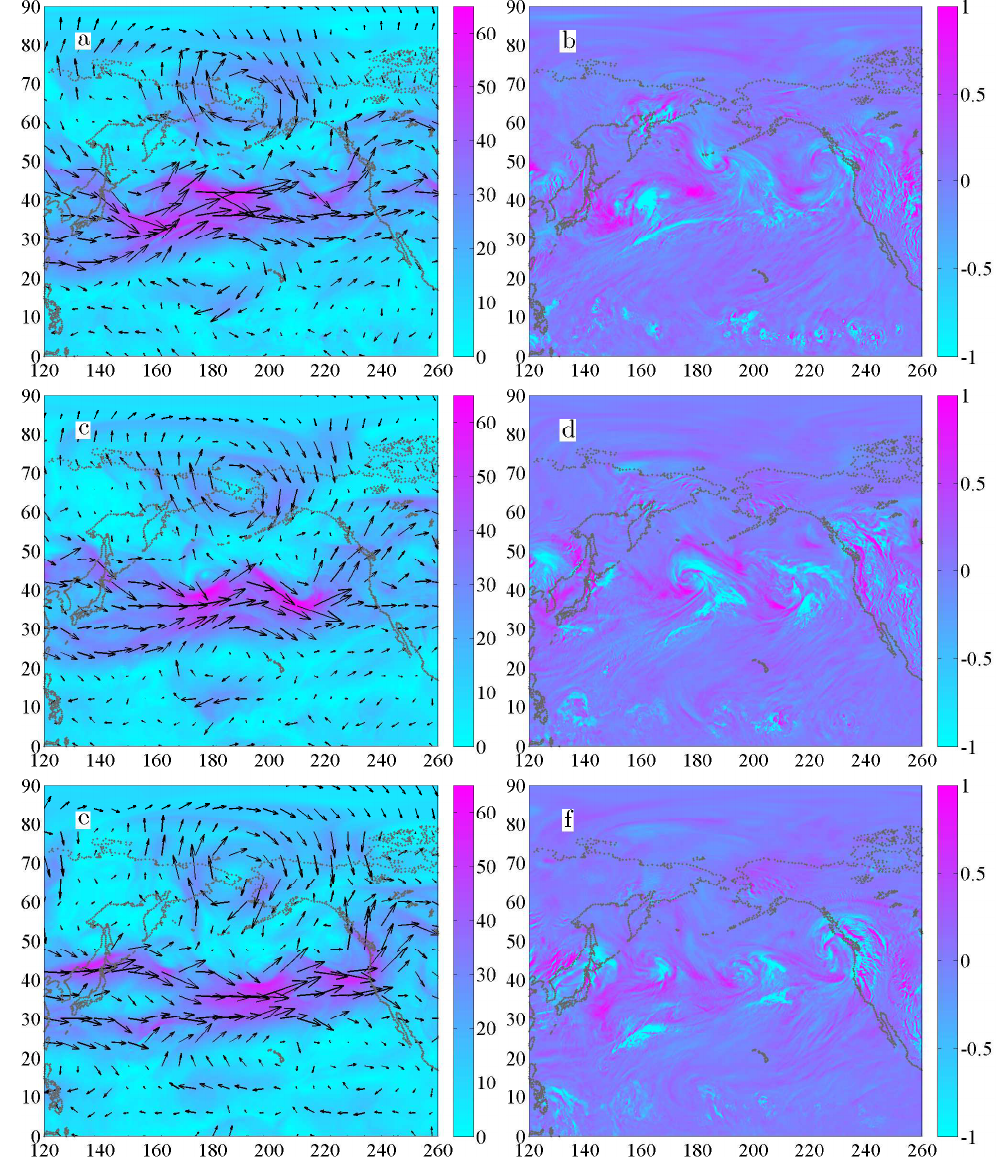
Fig. 2. The horizontal components u,v [ms − 1 ] (a, c, e) and the vertical component ω [Pas − 1 ] (b, d, f) of the wind speed at 500hPa on 12 March (a, b) , 13 March (c, d) , and 14 March (e, f) at 00:00UTC in the deterministic forecast. Axis labeling corresponds to geographical coordinates in degree.